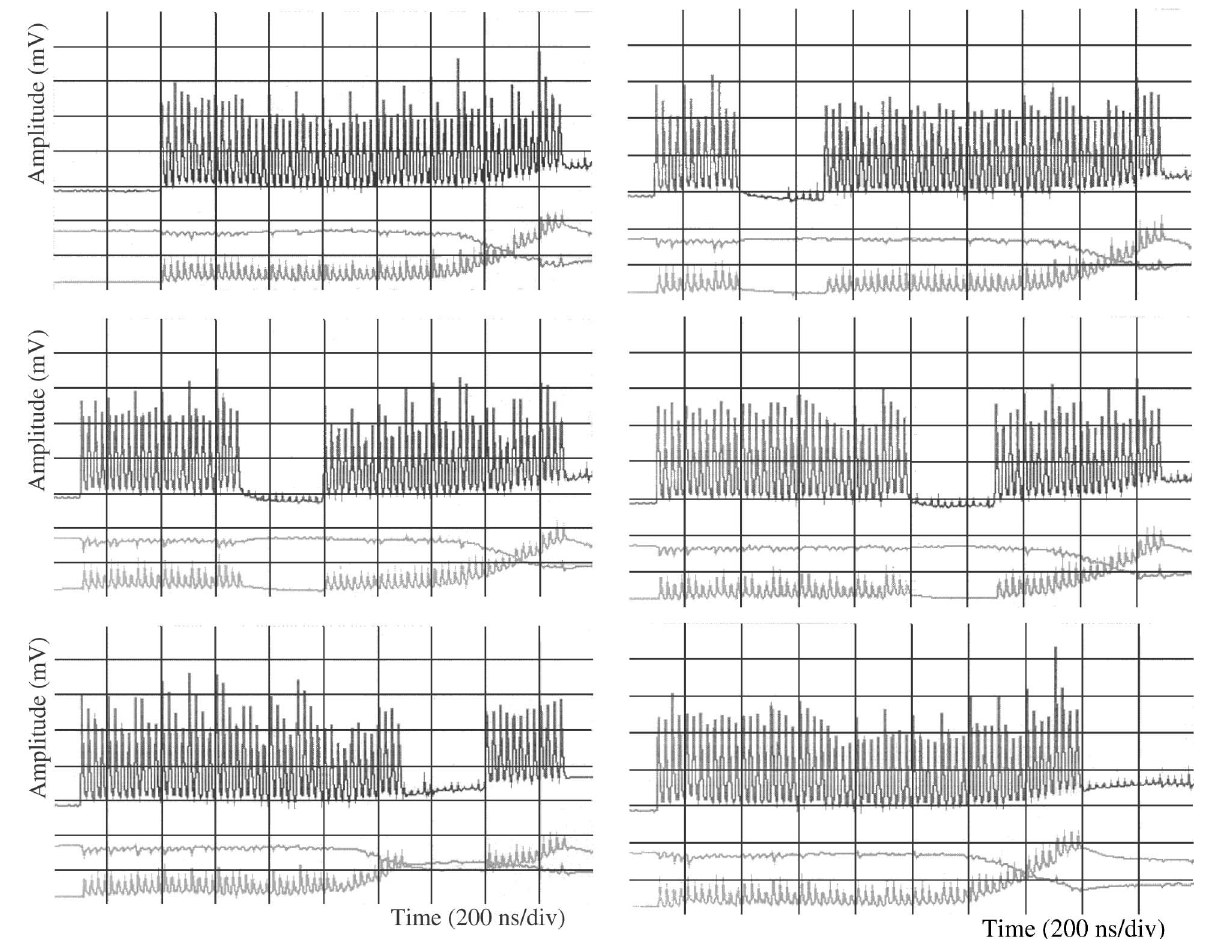
FIG. 5. Measured baseline drift in a TT2 electrostatic pickup, with 6 possible cases of 12 missing bunches. From top to bottom: (cid:21) ( 800 mV = div ), (cid:24) y ( 100 mV = div ), and (cid:24) x ( 100 mV = div ).